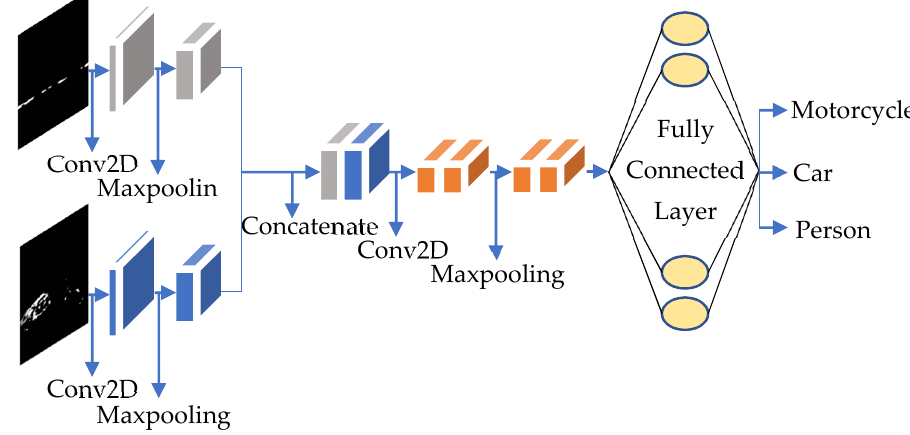
Figure 2. Proposed multi-input-based deep learning structure.